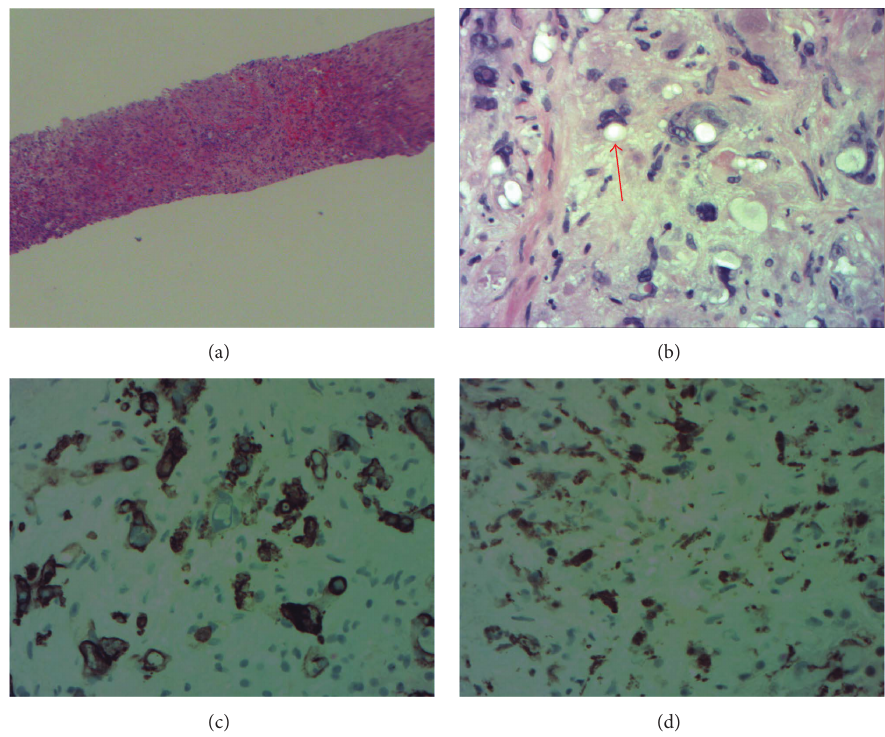
Figure 2: (a) Replacing hepatocytes is tumor with sometimes large, often spindled, aberrant nuclei amid abundant light pink, feathery matrixes(H&E,100x).(b)Uniformlydark,cancerousnuclei,sometimeshuge,lieinvariablycoloredcytoplasm,oftennotevident.Cancercells lie in isolation and in epithelioid groups. At the arrowhead, a group lies about a vacuole, which is a vascular lumen (H&E, 400x). (c) Cancer cell cytoplasm often expresses CD34, which emphasizes the epithelioid pattern (DAB, 400x). (d) Many cancer cell nuclei, often juxtaposed to vacuoles, express Factor XIIIa (DAB, 400x). Gold bars are 200 𝜇